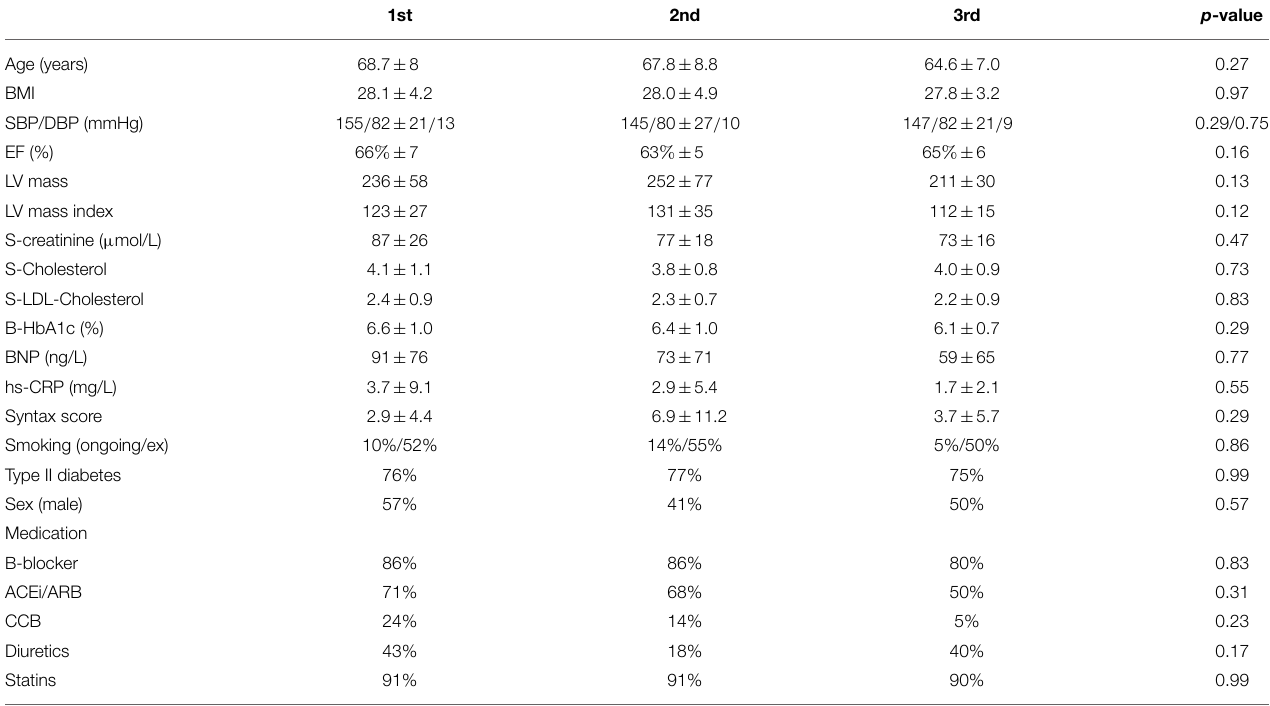
TABLE 1 | Characteristics of patients divided according to the amount of fibrosis measured by magnetic resonance